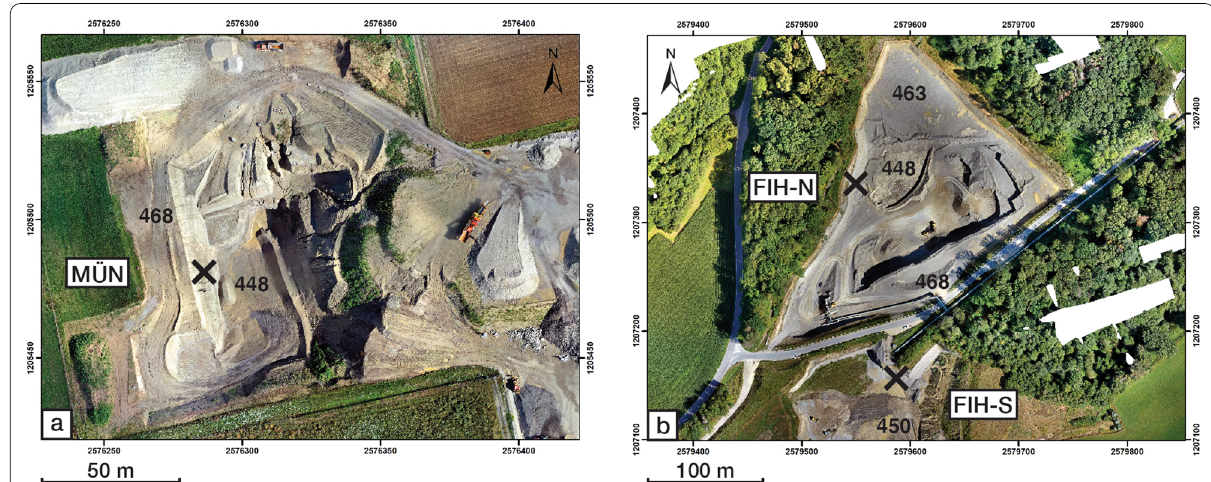
Fig. 2 Orthomosaic high-resolution pictures of the gravel pits at a Müntschemier (MÜN) and b Finsterhennen southern (FIH-S) and northern part (FIH-N). Crosses indicate the location of the sedimentological logs illustrated in Figs. 5, 6, and 7 (see these figures for coordinates of sections), and the numbers show the elevation in metres above sea